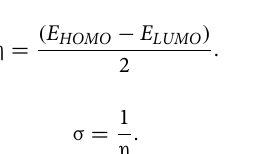
Figure 7. Carbon–carbon bond length variations, respectively, in the three structures of fullerenes, fulleranes, and fullerynes. The range of bond length changes starting from the lowest value, 1.10 the length of the carbon–hydrogen bond in fulleranes and fullerynes, until the maximum value, 1.57 to carbon–carbon bonding in fulleranes. The lengths of the single and triple bonds of the investigated fullerynes are 1.49 and 1.22 , Å